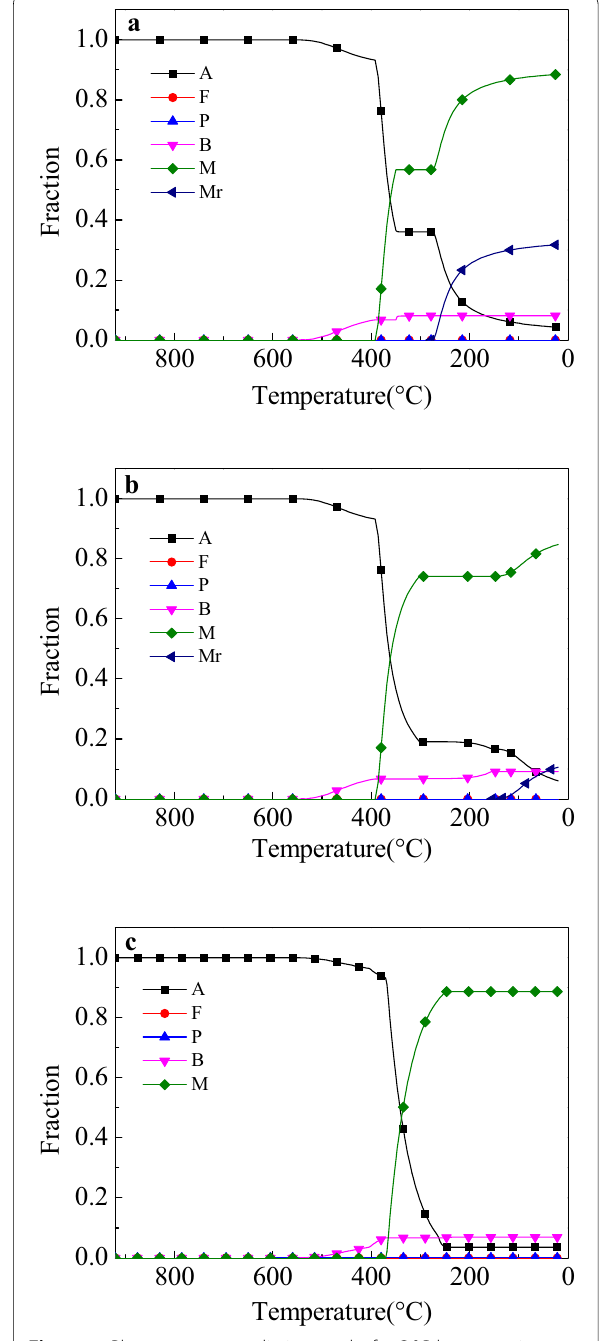
Figure 7 Phase content prediction results for Q&P hot stamping: a P T 350 °C; b P T 300 °C; c P T 250 °C (where A is austenite, F = = = is ferrite, P is pearlite, B is bainite, M is martensite and Mr is second